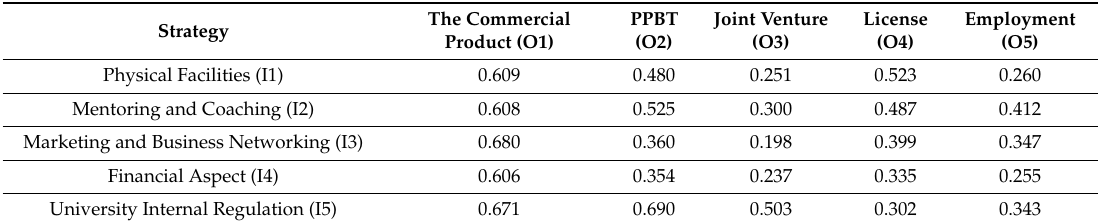
Table 8. Correlation value between e ffi cient DMU